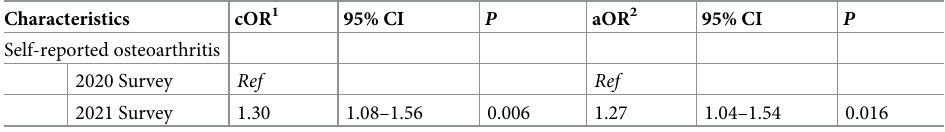
Table 3. Changes in prevalence of osteoarthritis after adjusting for potential covariates (n = 2077). Characteristics